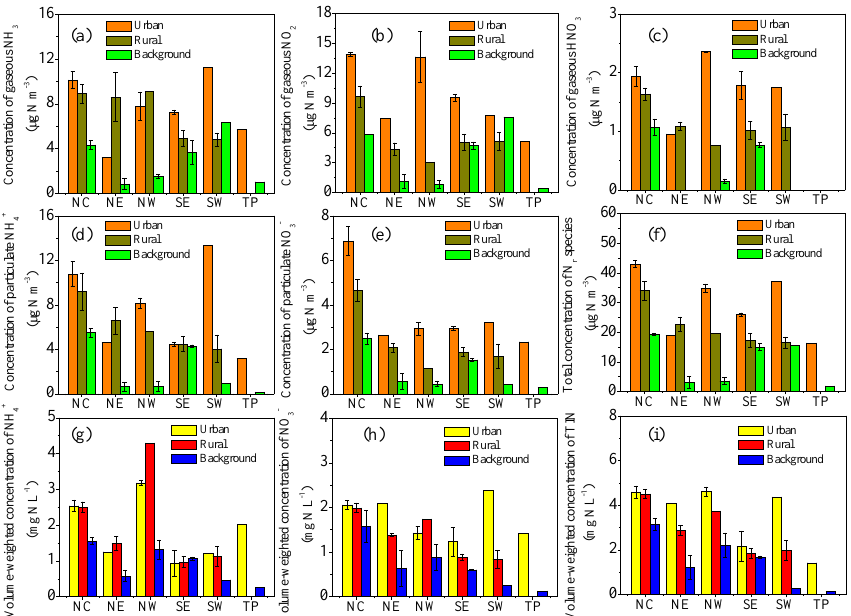
Figure 3. Annual mean concentrations of (a) NH 3 ; (b) NO 2 ; (c) HNO 3 ; (d) p NH + in air and volume-weighted concentrations of NH + at different land use types in six regions. The number of sites with the same land use type in each region can be found in Table S1 in the Supplement. The error bars are the standard errors of